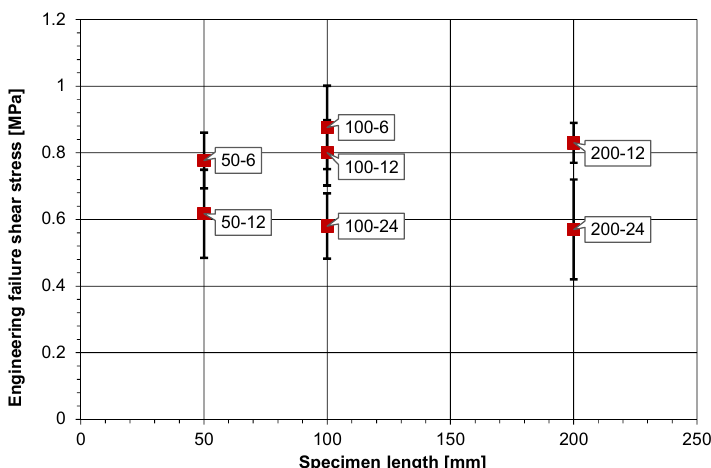
Fig. 27 Engineering stresses at failure plotted against the length of the specimen. The error bars indicate the standard deviation for each test